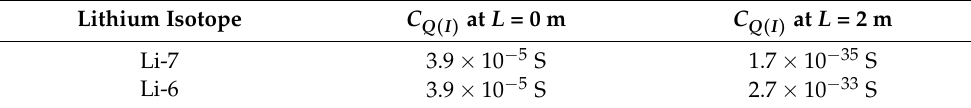
Table 10. The table shows that intracellular lithium isotopes can have a range of quantum conduc- tance of single channel from the value at L = 0 m to the value at L = 2 J according to the setting values in graph (b) of Figure